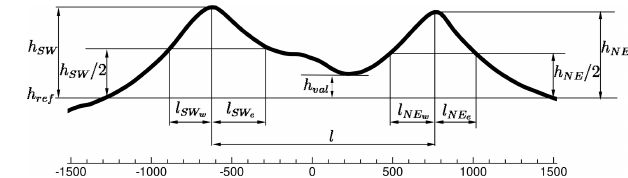
Figure 4. Terrain profile: geometrical parameters. Table 2. Main geometric variables of transects A, B, C and D (slope S in degrees, ◦ , and length and elevation (cid:96) and h in metres; h ref = 250ma.s.l.).